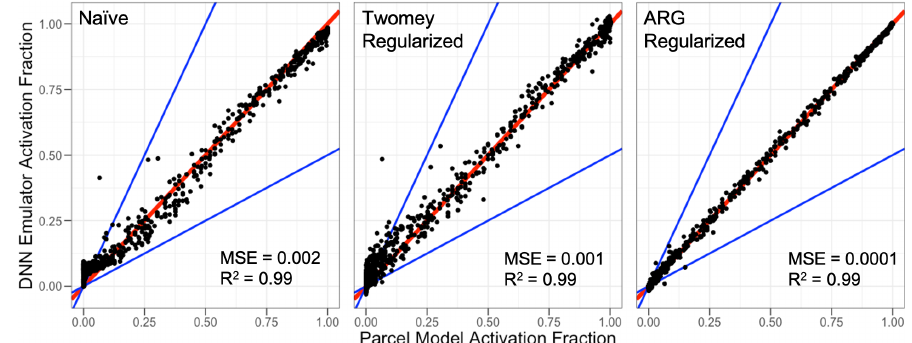
Figure 6. Activation fraction performance of the DNN emulators used here on the + 4K generalizability test dataset. The 1 : 1 line is in red, and the blue lines represent a factor of 2 difference. Performance statistics are given in each panel.